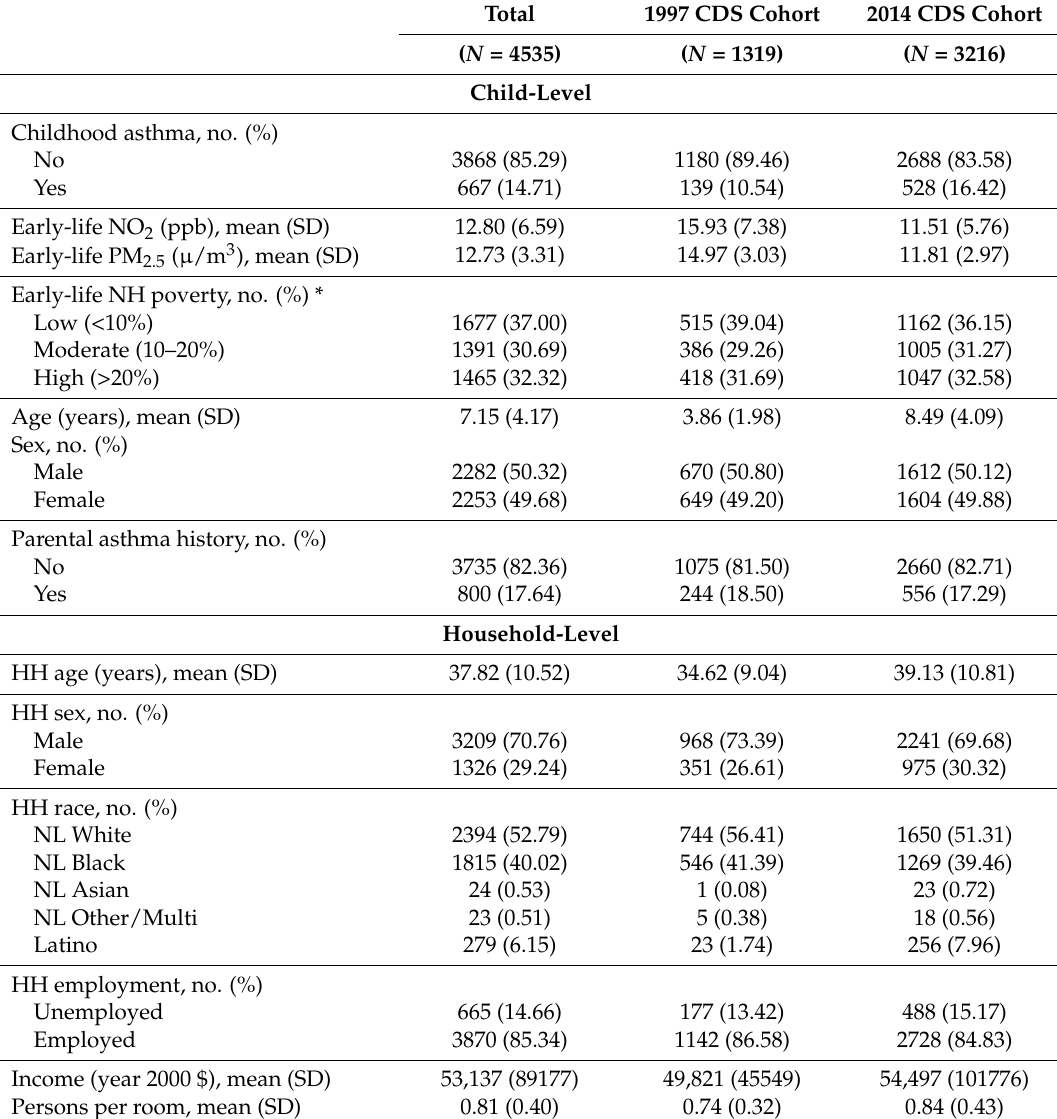
Table 1. Summary statistics, PSID-CDS,